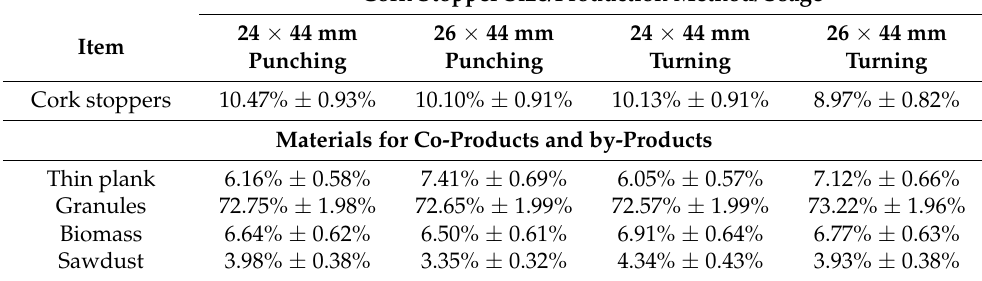
Table 2. Use rate of raw